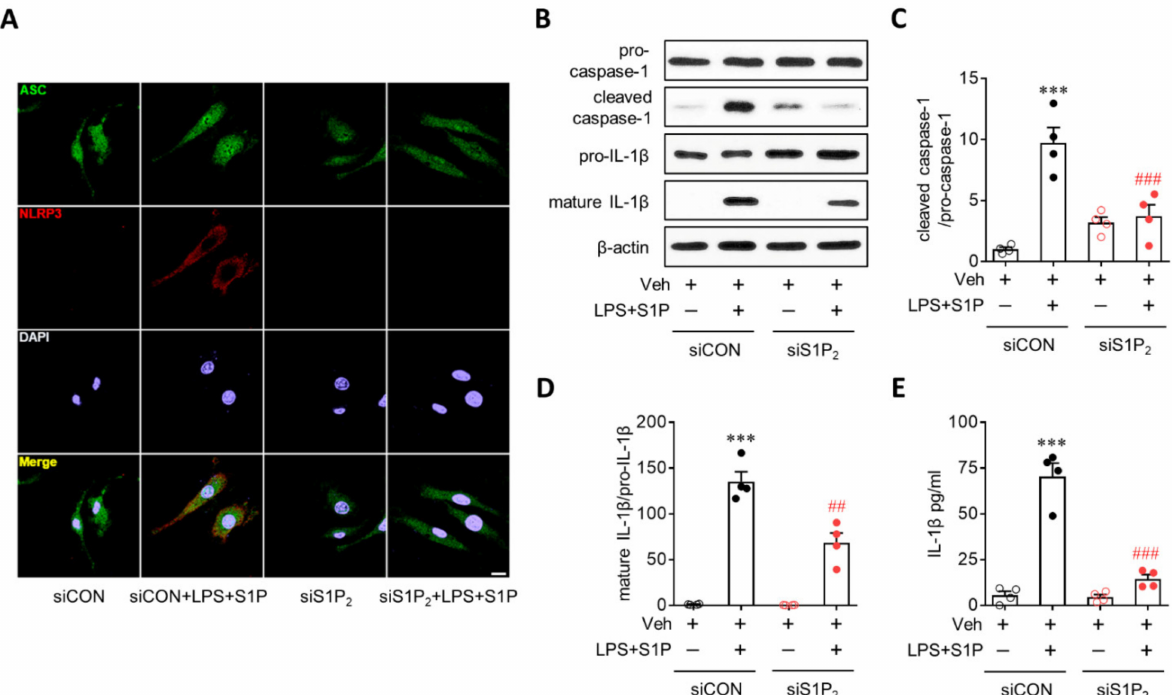
Figure 5. S1P 2 knockdown attenuates S1P-induced NLRP3 inflammasome activation in LPS-primed BMDMs. BMDMs transfected with non-target control siRNA (siCON) or S1P 2 -specific siRNA (siS1P 2 ) were primed with LPS (500 ng/mL) for 4 h and exposed to S1P (1 µ M) for 1 h. ( A ) Effects of S1P 2 knockdown on ASC speck formation were determined by double immunofluorescence for ASC (green) and NLRP3 (red) in LPS/S1P-treated BMDMs (LPS+S1P). Representative images of ASC speck formation in NLRP3-positive BMDMs. Scale bar, 10 µ m. ( B – D ) Effects of S1P 2 knockdown on caspase-1 activation and IL-1 β maturation were analyzed by Western blot. ( B ) Representative blots of pro-caspase-1, cleaved caspase-1, pro-IL-1 β , and mature IL-1 β . Quantification of caspase-1 activation ( C ) and IL-1 β maturation ( D ). ( E ) Effects of S1P 2 knockdown on IL-1 β secretion were measured by ELISA. n = 4 per group. *** p < 0.001 versus control BMDMs transfected with control siRNA (siCON + Veh). ## p < 0.01 and ### p < 0.001 versus LPS/S1P-treated BMDMs transfected with control siRNA (siCON + LPS +